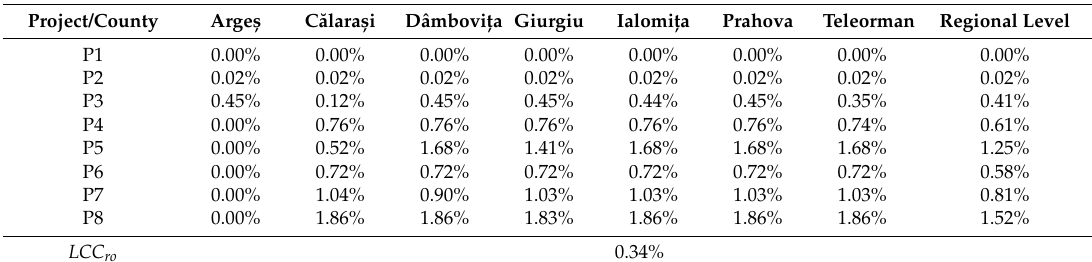
Table 5. LCC variation at the regional level for the maximum scenario (%) in the case of the increase of the implementation cost by 10%.